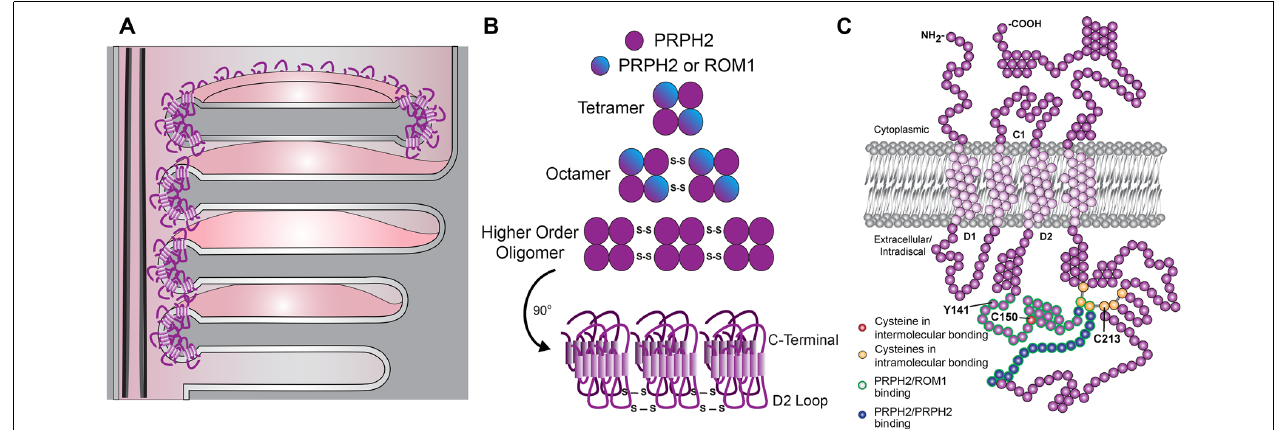
FIGURE 1 | Schematic representations of outer segment disc enclosure, peripherin-2 gene (PRPH2) oligomerization and PRPH2 molecular structure. (A) The base of a rod photoreceptor outer segment contains both “open,” nascent discs that are exposed to the extracellular space and “enclosed,” mature discs that are separated from the outer segment plasma membrane. In open discs, PRPH2 is located only at the discs rims adjacent to the connecting cilium. In enclosed discs, PRPH2 is located throughout the entire circumference of the disc. (B) The formation of PRPH2/ROM1 homo- and hetero-oligomers involves disulfide bonds between cysteines within the D2 loop of each molecule. (C) The molecular structure of PRPH2 is depicted with several features highlighted. Of note, the D2 loop contains seven cysteines: the C150 residue that is involved in intermolecular bonds for oligomerization and six that are involved in intramolecular bonds, including C213. This loop also contains the Y141 residue. Modified from Stuck et al. (2016) with permission by Elsevier.